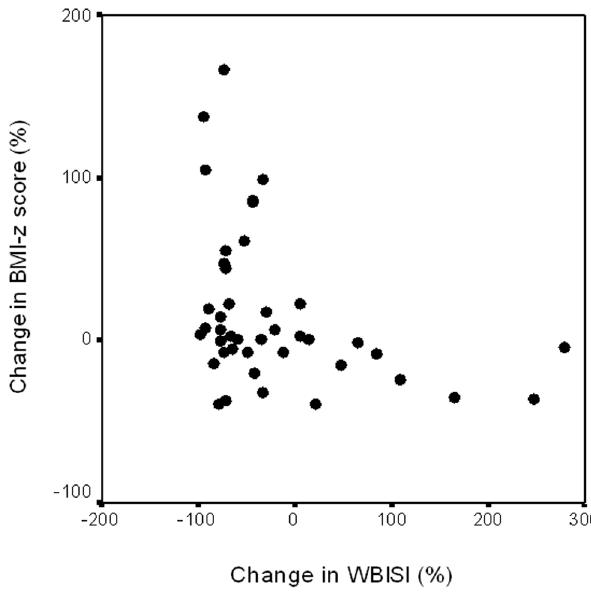
Figure 1. Relationship between percent changes in Whole Body Insulin Sensitivity Index (WBISI) and in BMI-z score (y= 2 0.6622x–11.194).